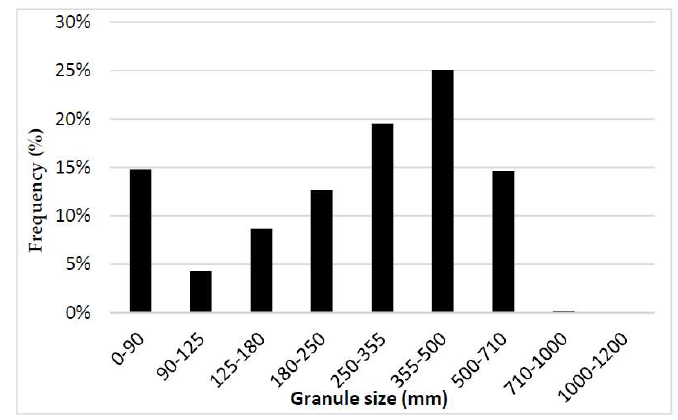
Figure 4. Granule size distribution of mefenamic acid formulation.